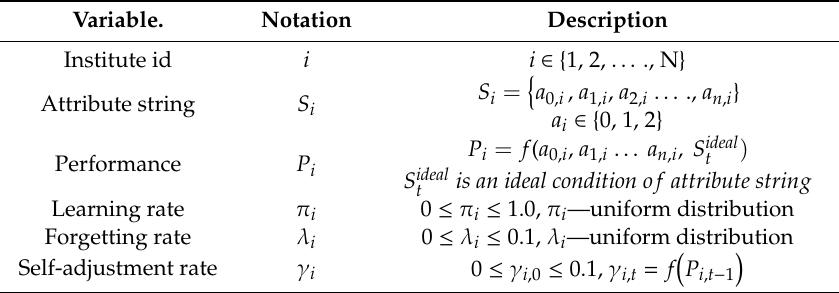
Table 2. The list of attribute in the agent layer.